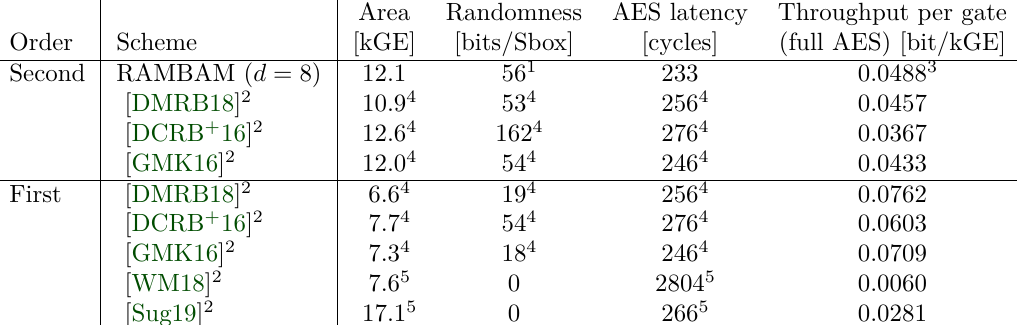
Table 3: AES-128 realization area and performance comparison for schemes with 1 Sbox